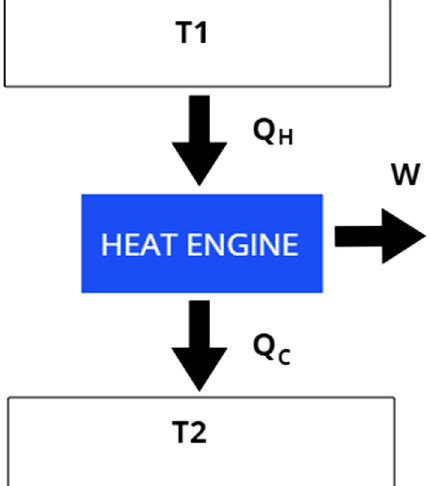
Fig. 3 A 2T heat engine